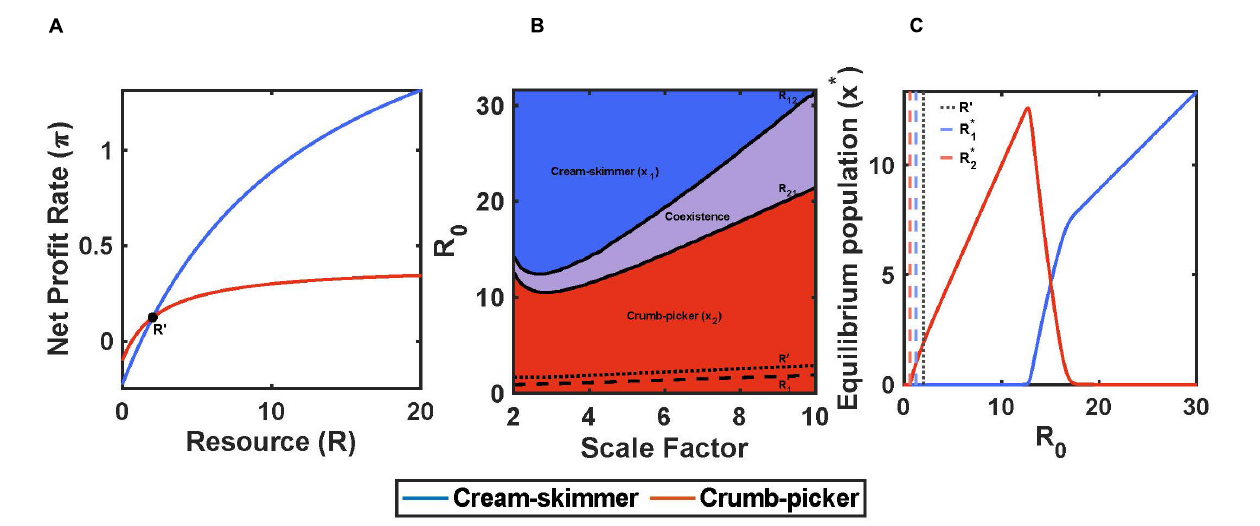
FIGURE 3 | Handling time and cost of existence trade-off with pulsed resource. (A) The crumb-picker has the higher net profit rate than the cream-skimmer at low values of R . R (cid:48) represents the resource level where both species have the same net profit rate. (B) Regions of competitive exclusion and coexistence change due to initial pulse size R 0 and the scale factor µ . (C) For µ = 5, equilibrium populations change as a function of R 0 . Intermediate values of R 0 show species coexistence. Parameters: µ = 5, h 2 = 2, h 1 = h 2 / µ , c 2 = 0.1, c 1 = c 2 +(0.025* µ ), b 1 = b 2 = 0.5, a 1 = a 2 = 0.2, T = 10, R 0 = 10, x 1 (0) = 10, x 2 (0) =